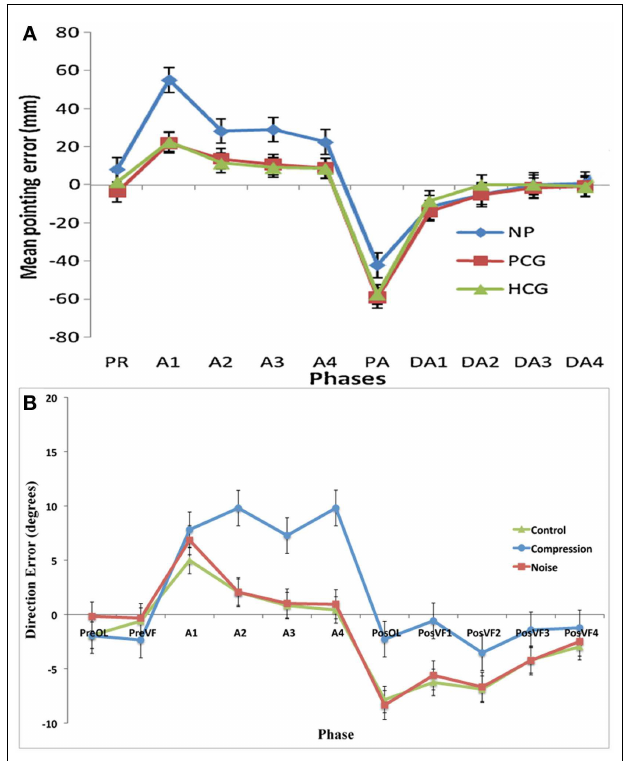
FIGURE 4 | (A) Data adapted from Aimola et al. (2012) showing the mean pointing error in millimeter (with SE bars) in each group across five phases: PR, Pre-adapt; A, adaptation; DA, Deadaptation or aftereffect; NP, neglect patients; PCG, patient control group; HCG, healthy control group; (B) Current data showing the mean pointing error (with SE) in degrees for the first trials in each phase: PreOL, pre-open loop; PreVF, pre-visual feedback; A (Prism-Adaptation), PosOL; post-open loop; PosVF, Post-visual feedback/deadaptation. Data from Aimola et al. show the means of no visual feedback trials from each block of